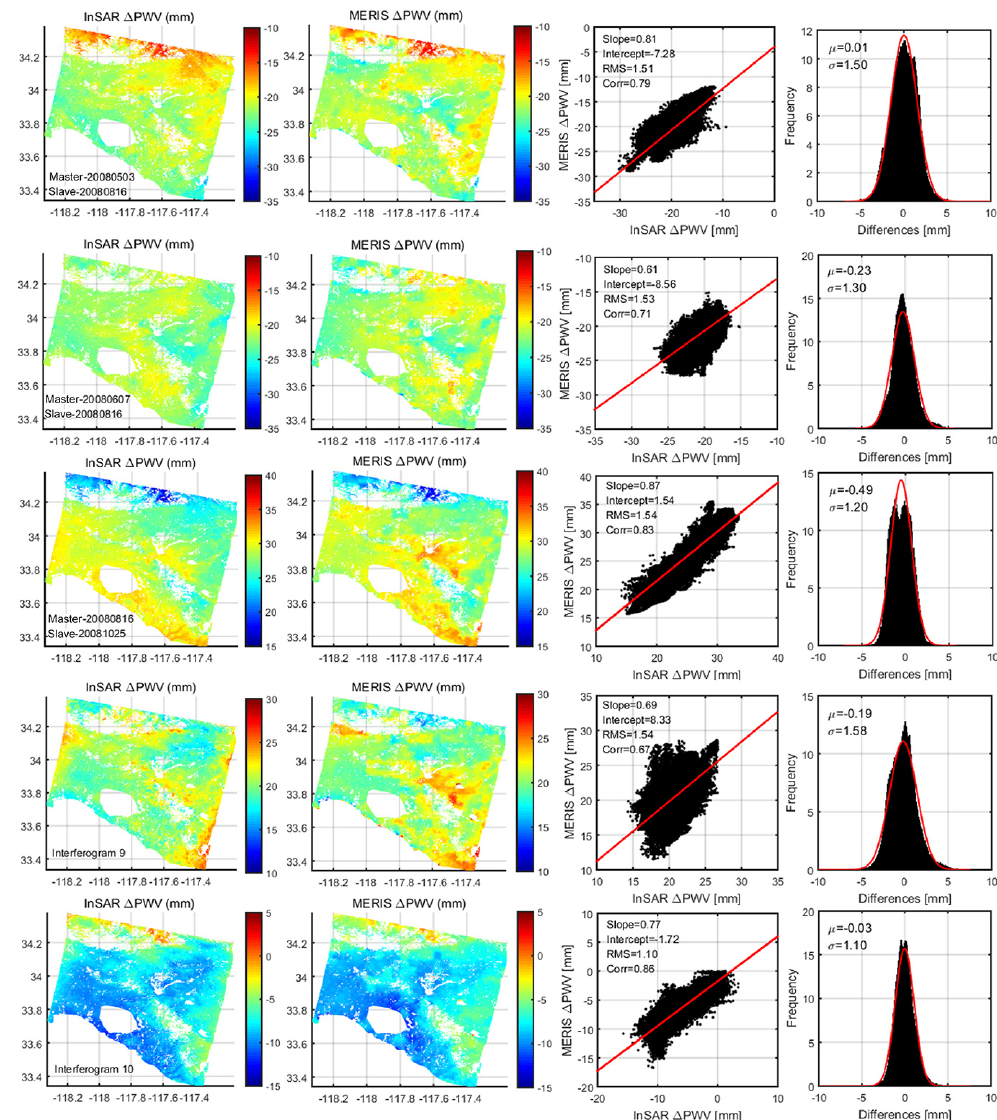
Figure 11. Comparison of the (cid:49) PWV maps derived from InSAR and MERIS. For all images here, the root mean square (rms), correlation (Corr), differential mean ( µ) and standard deviation ( σ) are